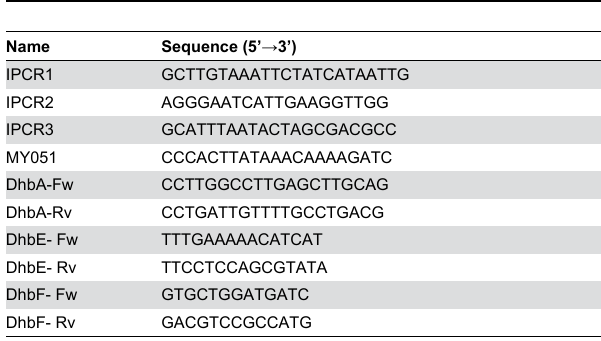
Table 2. Oligonucleotides used in this